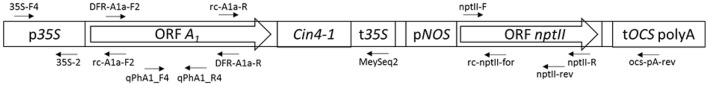
Schematic representation of the transgenic insert found in the three GE-petunia varieties cvs. Salmon Ray, Viva Orange and Electric Orange (NCBI MF521566) p35S, promoter sequence of the 35S Cauliflower mosaic virus gene; A1, coding sequence of the A1 gene; Cin4-1, partial Cin4-1 transposable element present in type 2 allele of A1 according to Schwarz-Sommer et al. (1987a,b); t35S, terminator sequence of the 35S Cauliflower mosaic virus gene; pNOS, promoter sequence of the nopaline synthase gene; nptII, coding sequence of the neomycine phosphotransferase II selectable marker gene; tOCS, terminator sequence of the octopine synthase gene. Positions of primers are marked by arrows. Primer sequences are provided in Supplementary Table S1.